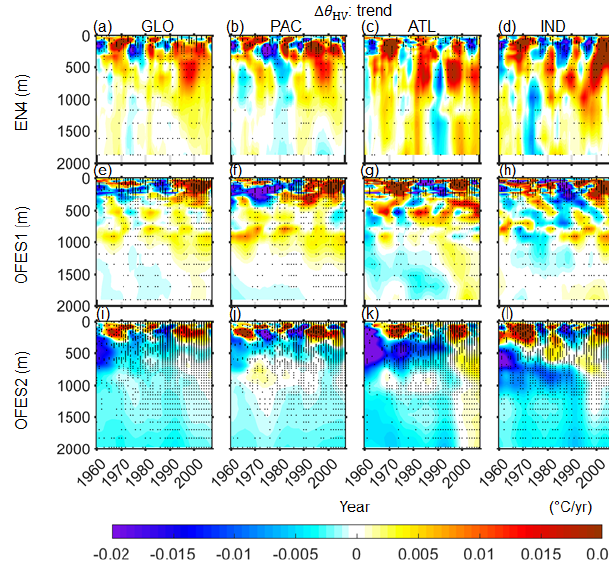
Figure 12. Depth–time patterns of the horizontally averaged poten- tial temperature change from the HV component, (cid:49)θ HV , for (left to right) the global, Pacific, Atlantic, and Indian oceans. Top to bot- tom: EN4, OFES1, and OFES2. Horizontal axis: year; vertical axis: depth in m.